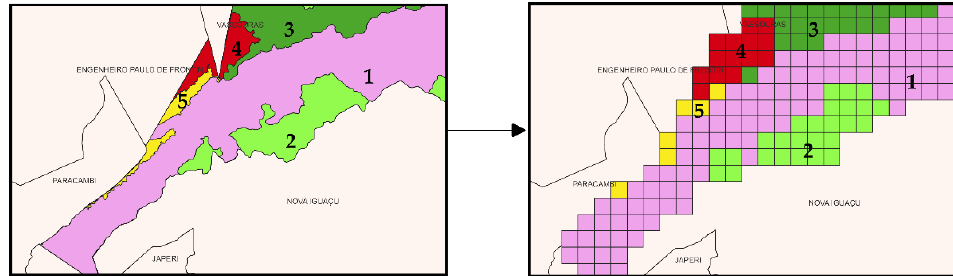
Figure 7. Example of the use of the Zonal Statistics algorithm in the geodiversity map of Miguel Pereira municipality, Rio de Janeiro State, Brazil. The algorithm calculated, by “majority”, the attributes of the 1 × 1 km grid cell which overlaps the geodiversity map (previously converted to a raster layer map). 1-Mountainous Relief constituted by Orthogneisses and Migmatites; 2-Dissected Plateaus; 3-Graben’s Edge Escarpment; 4-Mountainous Relief constituted by Granitoids; 5-Santana River’s Floodplains.